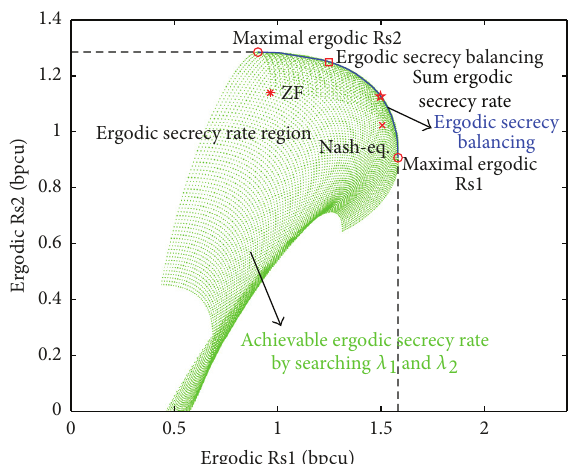
Figure 2: Ergodic secrecy rate region with 0 dB SNR for a random channel realization.